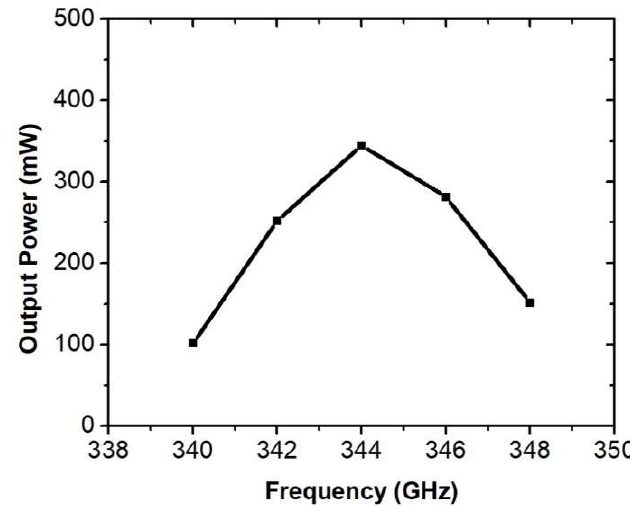
Figure 11. Output power of HHTWT.